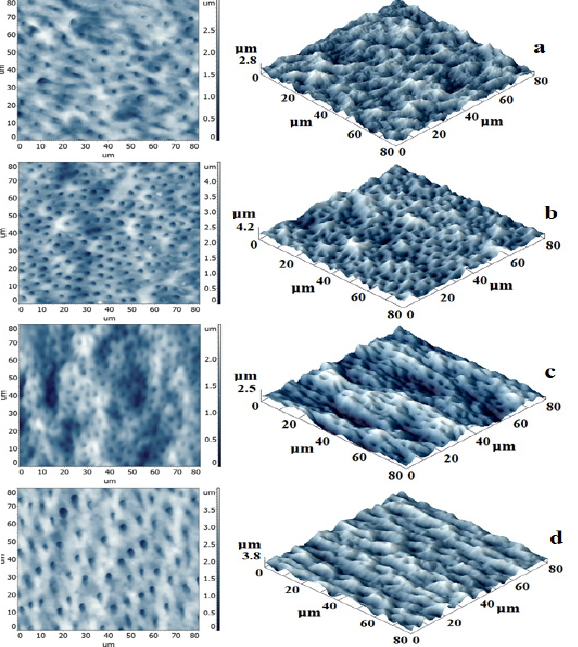
Figure 4. AFM images of sealer/dentin interface: bidimensional- left and tridimensional -right. ( a )-E1-DCR, ( b )-E2-BC, ( c )-RS, ( d )-TF-BC).